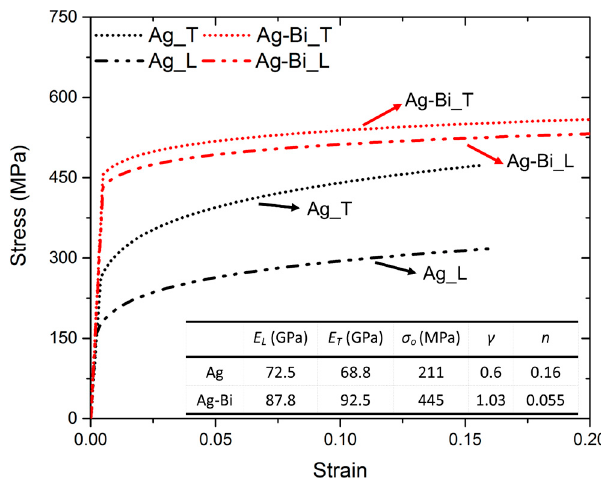
Figure 8. The inverse calculated flow stress for Ag and Ag-Bi in L and T directions ( Ag_T , Ag_L , Ag-Bi_T , and Ag-Bi_L denote the flow stress of Ag coating in the T direction, Ag coating in the L direction, Ag-Bi coating in the T direction, and Ag-Bi coating in the L direction, respectively).